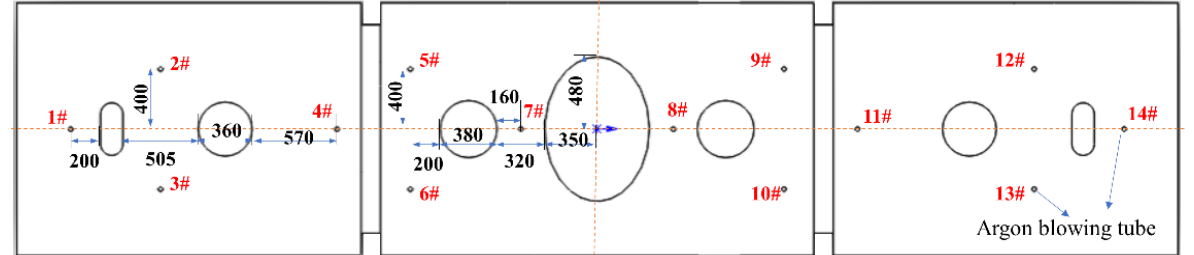
Figure 2. Arrangement of the argon blowing pipe on the two-strand slab tundish cover (mm).